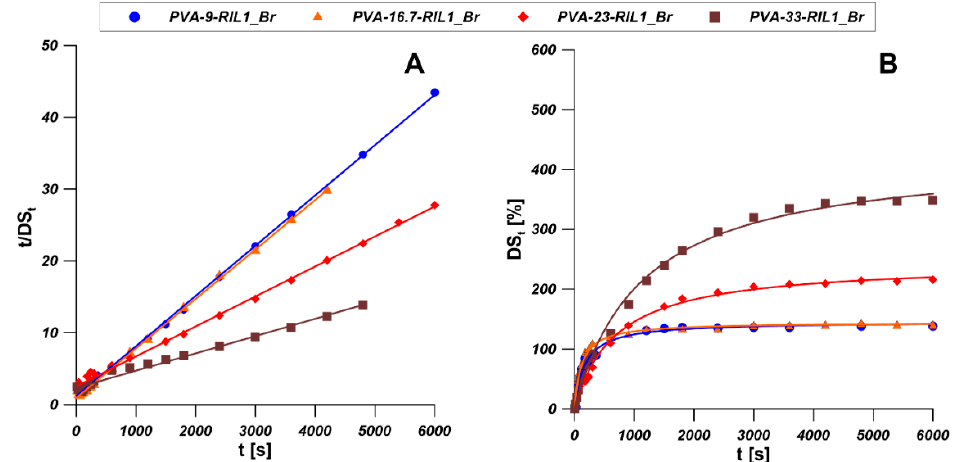
Figure 12. Experimental data of water sorption of PVA-RIL1_Br membranes fitted by linear ( A ) and non-linear ( B ) forms of PSO kinetic model.